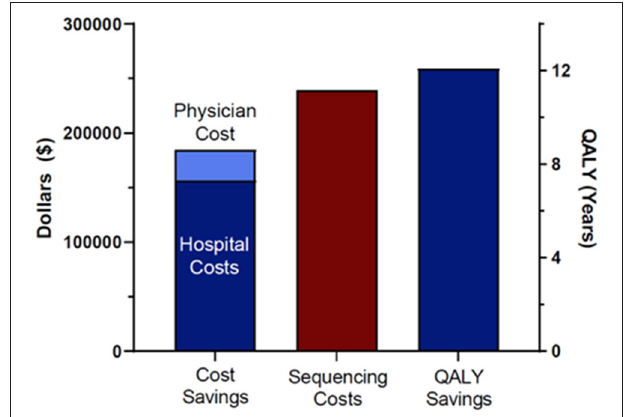
FIGURE 1 | Cost savings, sequencing costs, and QALY saving. Sequencing costs included all 38 patients in the original cohort and their family members.